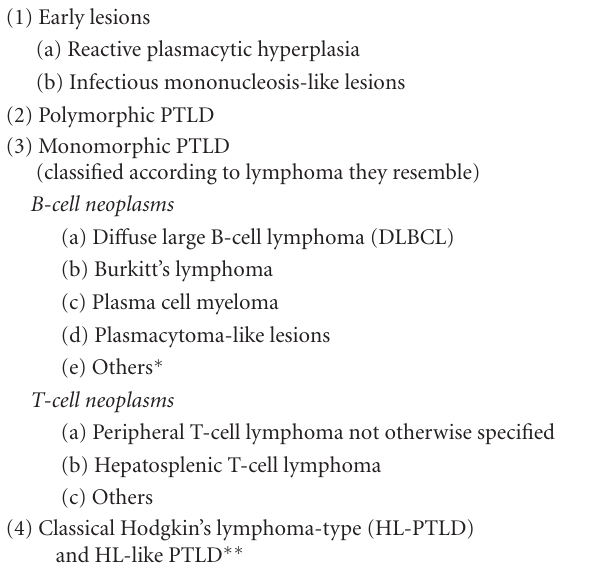
Table 3: Categories of posttransplant lymphoproliferative disor-